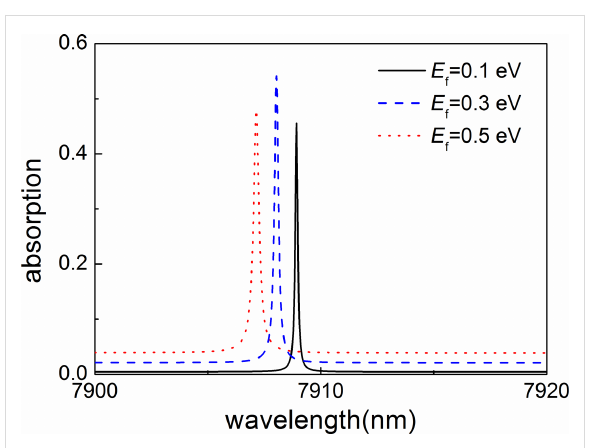
Figure 7: Absorption spectra with different Fermi levels. The geometric parameters of the absorber are the same as before.